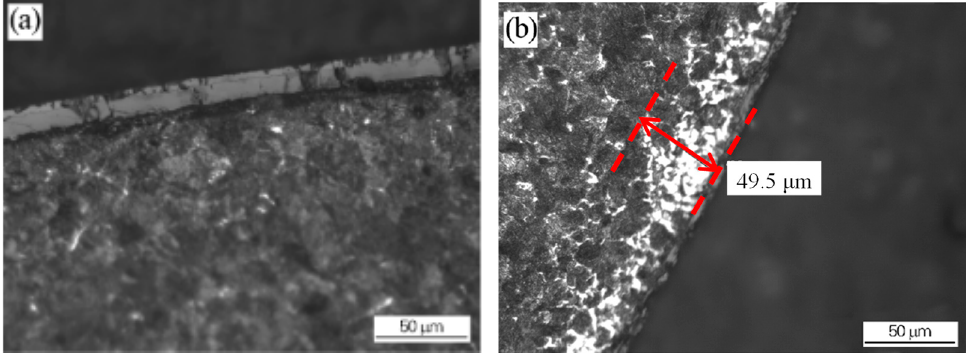
Figure 6. Decarburization of wire rod rolled at different spinning temperatures: ( a ) 1000 °C NS ( b ) 895 °C. Reprinted with permission from ref. [10].